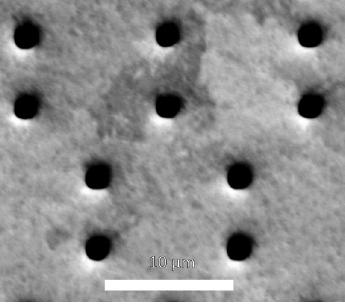
Figure 5. Back-scattered scanning electron microscope image of the MURA detail taken with a Zeiss EVO MA10 scanning electron